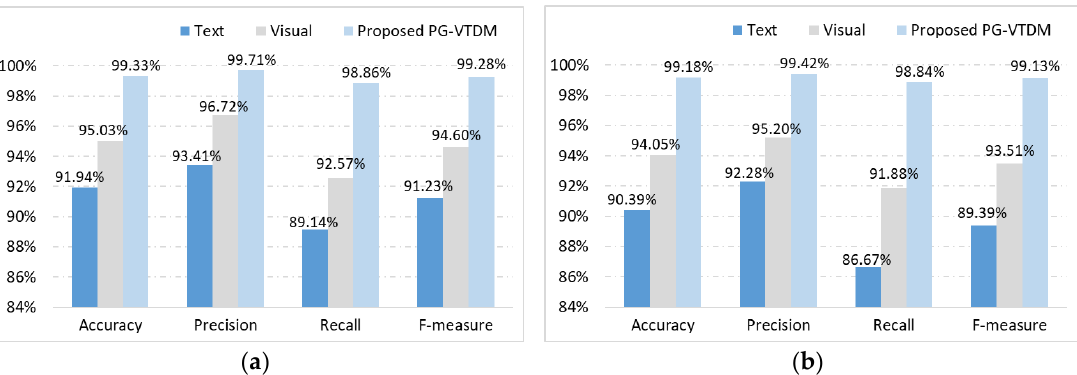
Figure 5. Performance comparisons between the single-feature-detection methods and the proposed PG-VTDM: ( a ) pornographic websites dataset and ( b ) gambling websites dataset.